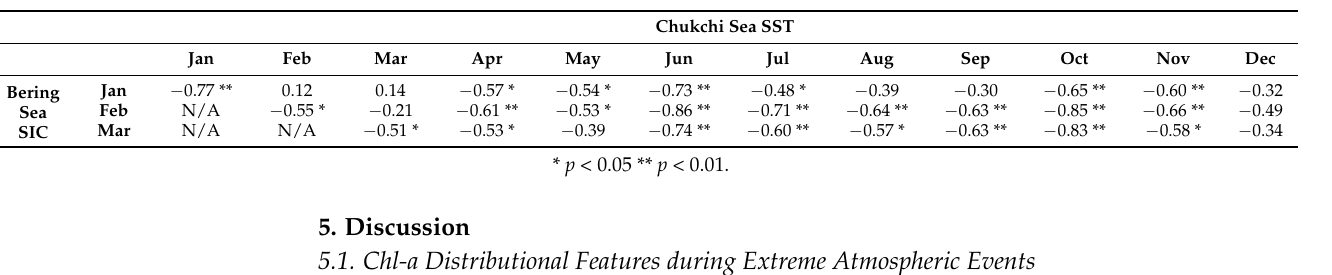
Table 2. Correlation between January to March SIC in the northern Bering Sea (165–180 ◦ W, 60–66 ◦ N ) and SST during following months in the eastern part of Chukchi Sea (160–170 ◦ W, 66–72 ◦